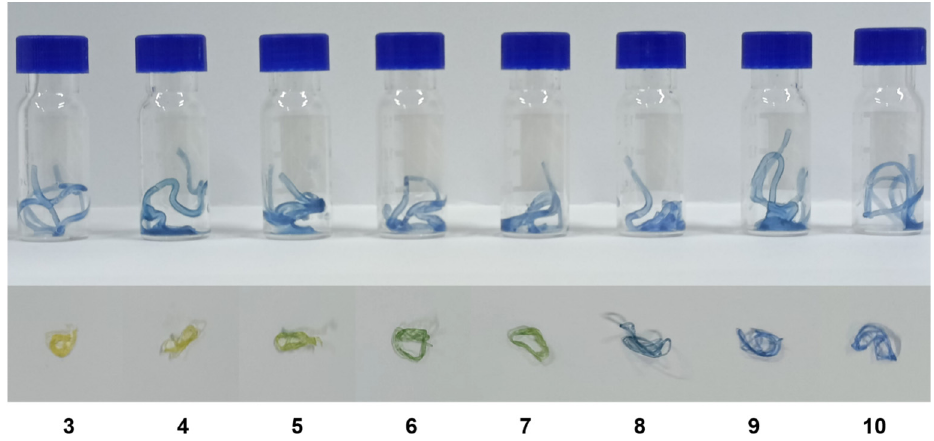
Figure 12. Discoloration of hydrogel fibers at different pH values (pH 3–10) (the numbers represent pH values). Table 1. H-values corresponding to discoloration of hydrogel fibers at different pH ranges (pH 3–10). pH